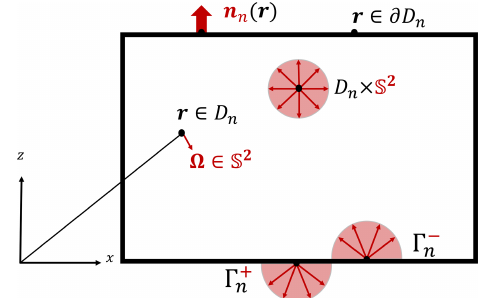
Figure 3. A side view of the n th RT domain illustrating several key definitions, such as the internal, incoming, and outgoing sets and the normal vector. Directional quantities are shown in red, while posi- tional quantities are shown in black. See Eq. (11) and the associated discussion in the main text for more